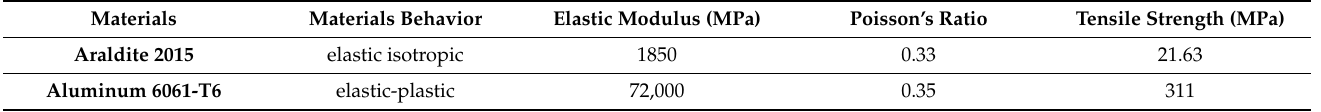
Table 1. Mechanical properties of aluminum plate and adhesive [26,30].